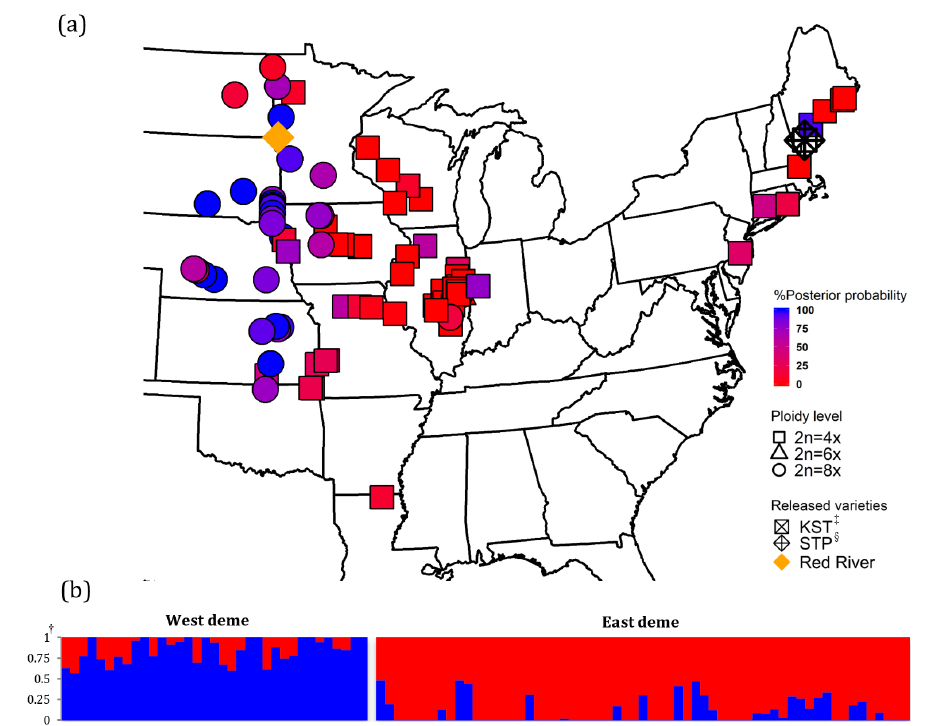
Figure 1. Geographical distribution of prairie cordgrass collections. ( a ) Map of collection in native range. Three shapes correspond to three levels of ploidy as indicated by the legend. Rectangle, circle, and triangle represent tetraploids, octoploids, and hexaploids, respectively. The populations were colored in a gradient scale based on the probability of membership assigned to two groups. ( b ) Bar charts showing posterior probabilities of assignment to two groups based on algorithms of variational Bayesian framework ( fastStructure ) and discriminant analysis of principal components ( DAPC ) using 9315 SNPs data. † : Bayesian-based posterior probability calculated from fastStructure and DAPC ; ‡ : KST = Kingston germplasm, Big Flats plant material center, NY; § : STP = Southampton germplasm, Big Flats plant material center,